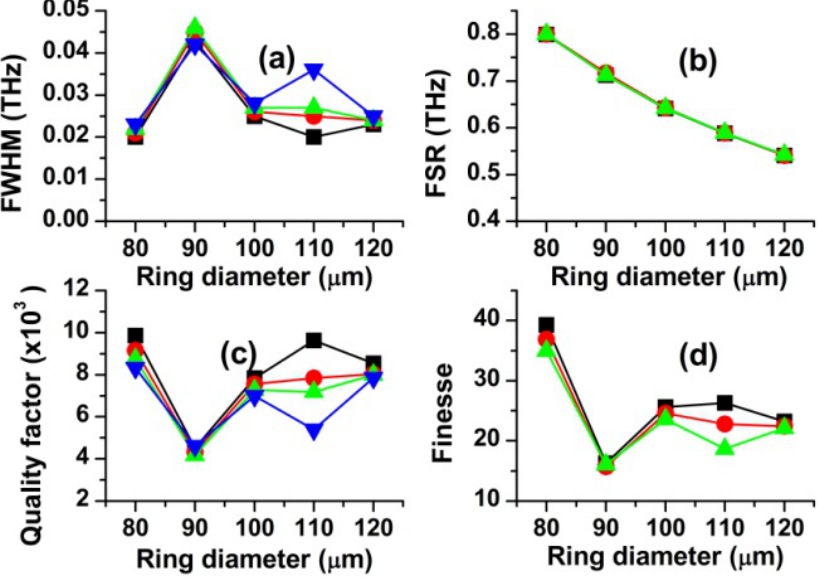
Figure 5. Effects of the ring diameter on the resonance characteristics (t = 3 μ m, w = 2 μ m, g = 0 μ m). Displayed four data sets are obtained from adjacent resonance peaks,